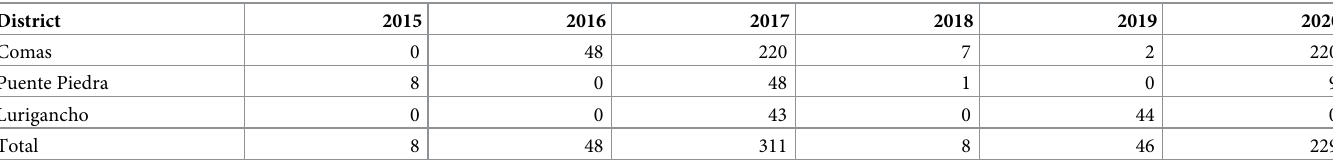
Table 2. Reported cases of dengue from 2016 to 2021 (unit: Cases per year).